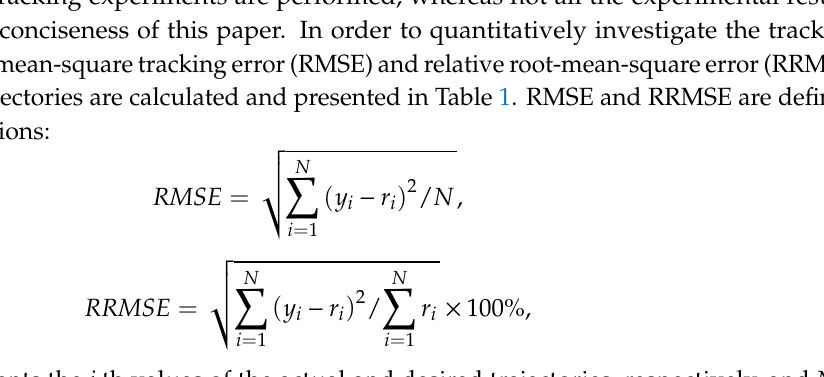
Figure 7. Tracking of the 50 Hz sinusoidal trajectory: ( a ) Time plot and ( b ) tracking error.